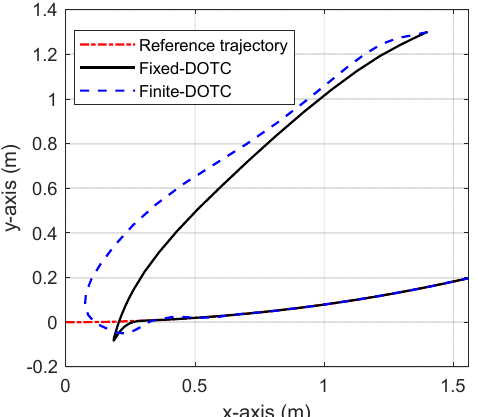
Figure 13. The actual position trajectory and the desired position trajectory in part 3.